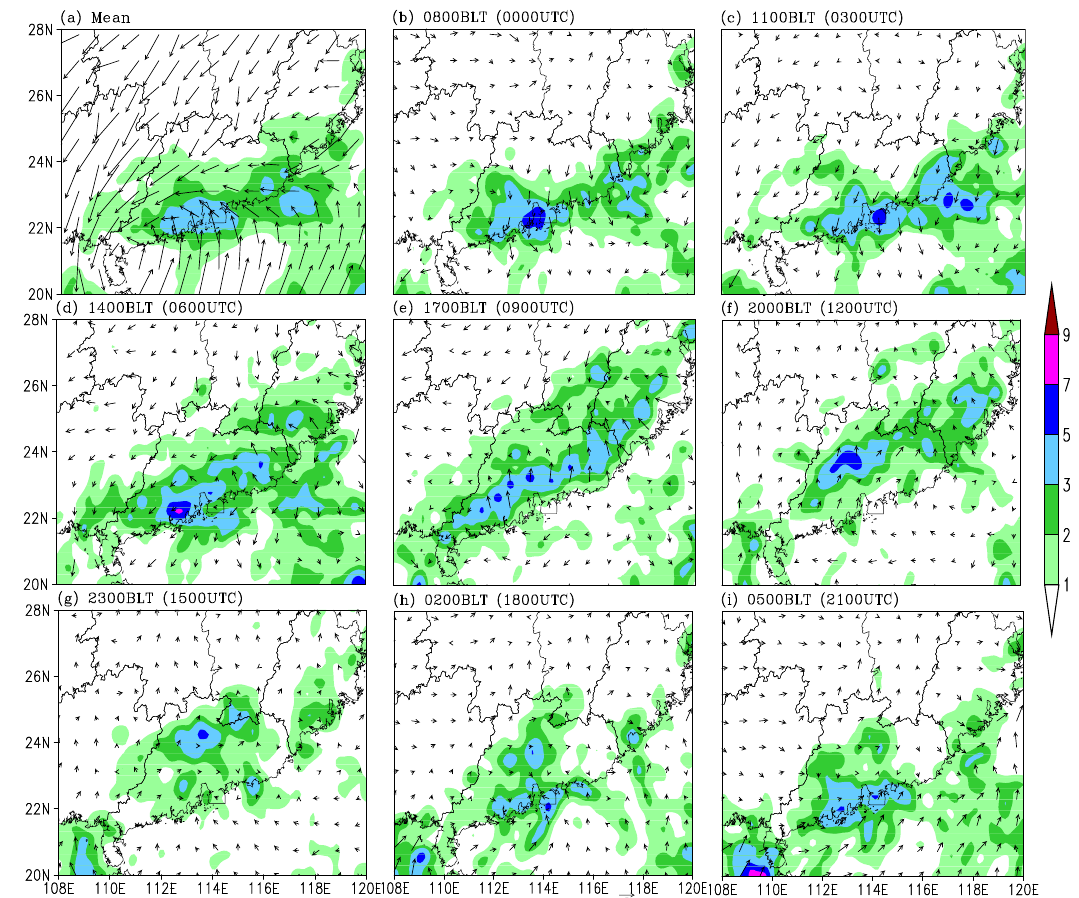
Figure 9. The results of Exp CTL for mean hourly rainfall (shaded, unit: mm) and 10-m wind (contours, unit: m·s –1 ) ( a ) and the diurnal evolution of rainfall intensity (shadings, unit: mm·h –1 ) and anomalous 10-m wind (vectors, unit: m·s –1 ) at ( b ) 0800 BLT, ( c ) 1100 BLT, ( d ) 1400 BLT, ( e ) 1700 BLT, ( f ) 2000 BLT, ( g ) 2300 BLT, ( h ) 0200 BLT and ( i ) 0500